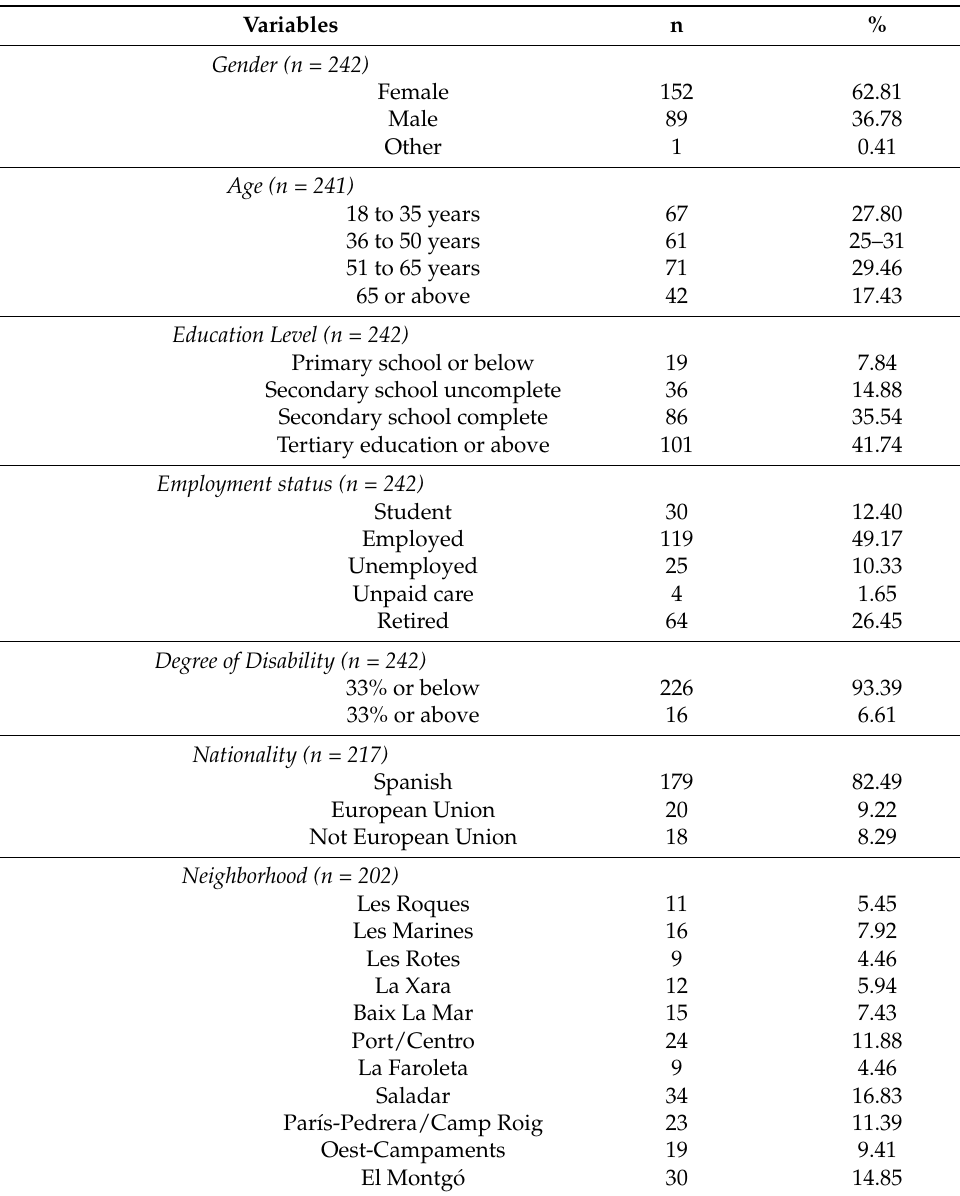
Table 2. Sociodemographic characteristics of the